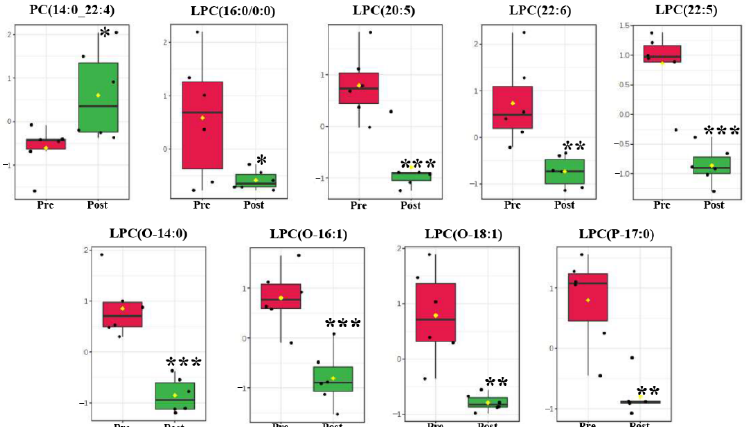
Figure 3. Significantly changed glycerophosphocholines between pre- and post-pubertal molting groups. Values are mean and standard deviation. Pre, pre-pubertal molt group. Post, post-pubertal molt group. Asterisks *, **, and *** denote significant difference at the p < 0.05, p < 0.01, and p < 0.001 levels, respectively.